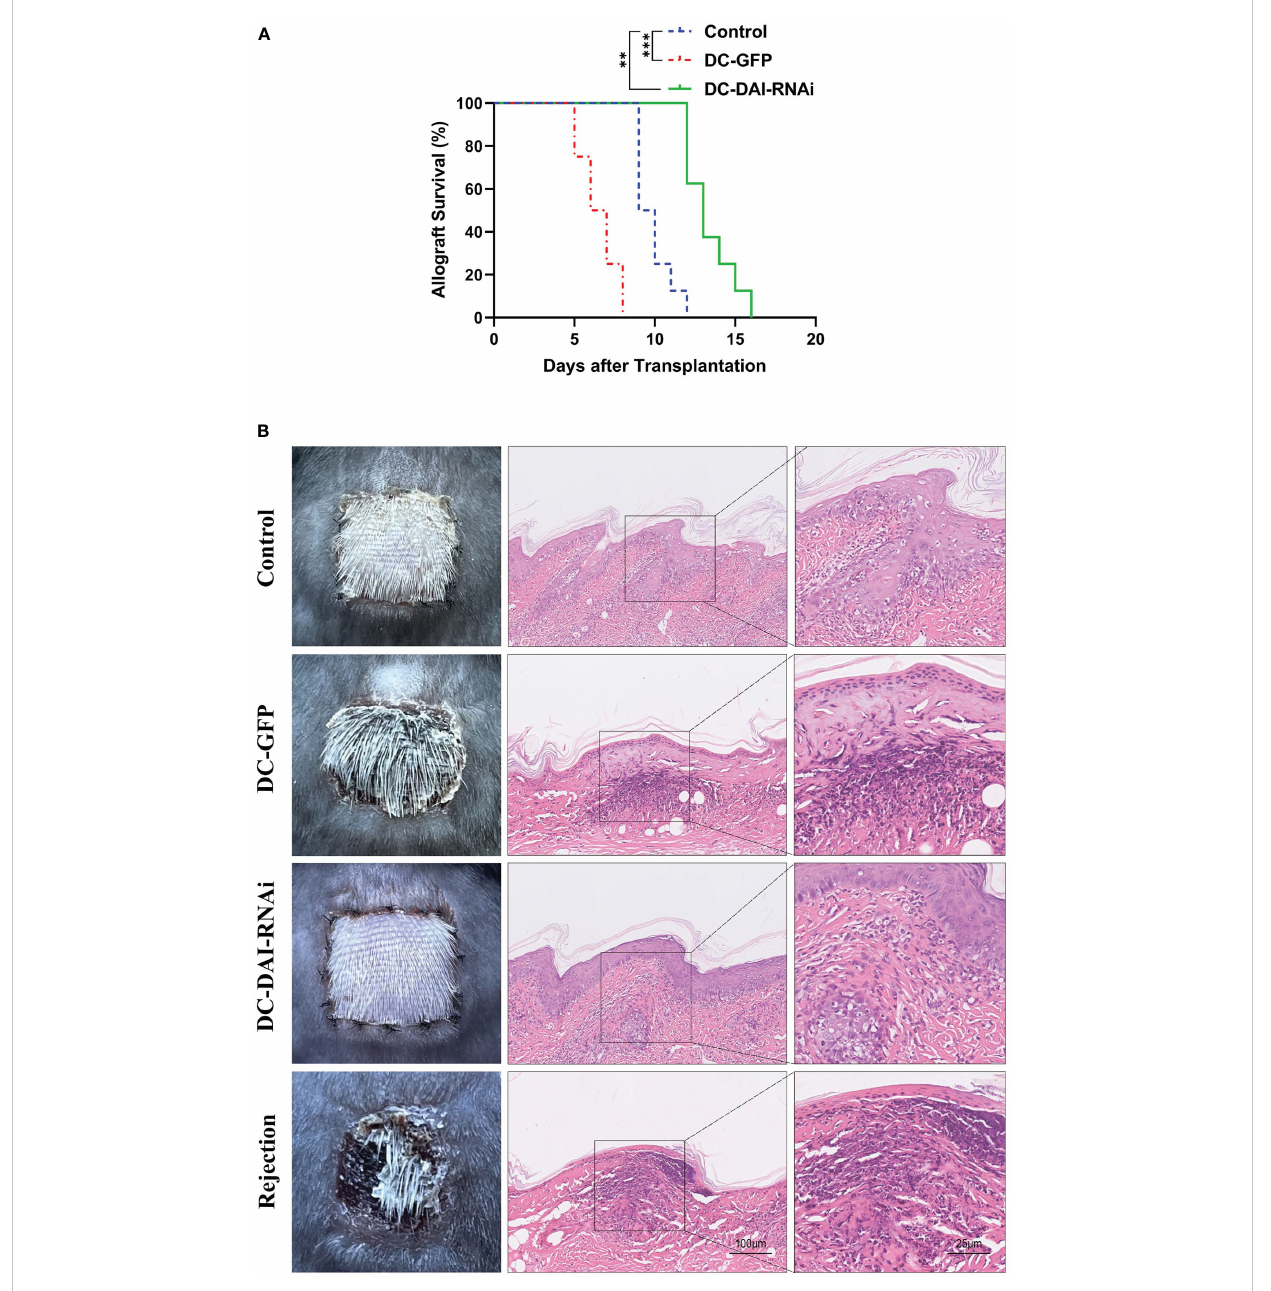
FIGURE 5 DCs transduced with AdV-DAI-RNAi-GFP prolonged the survival of the skin allograft. (A) Survival curves of skin allografts in the PBS control, DC- GFP, and DC-DAI-RNAi groups. Allograft survival among groups was compared with Kaplan – Meier analysis (**P < 0.01, ***P < 0.001, n=8). (B) On POD 7, skin allografts were removed from each group and stained with hematoxylin – eosin (HE). Skin allografts in the DC-DAI-RNAi group showed better survival with complete tissue structure and less lymphocyte in fi ltration (× 200,